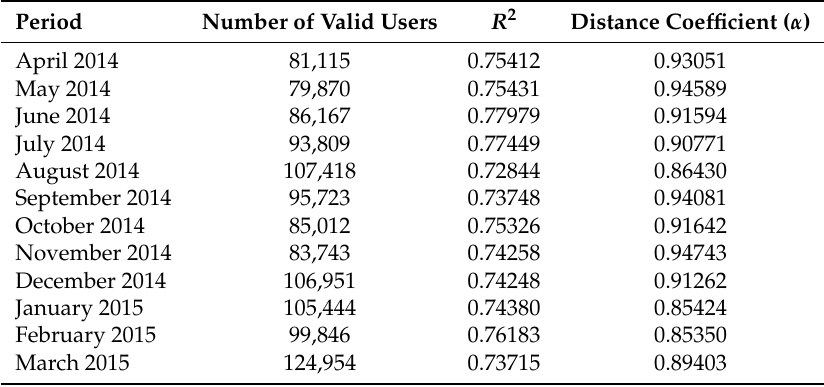
Table 1. Number of valid users and the results of the multi-regression analysis: Each coefficient of determination is greater than 0.72, so the multiple regression model fits the data